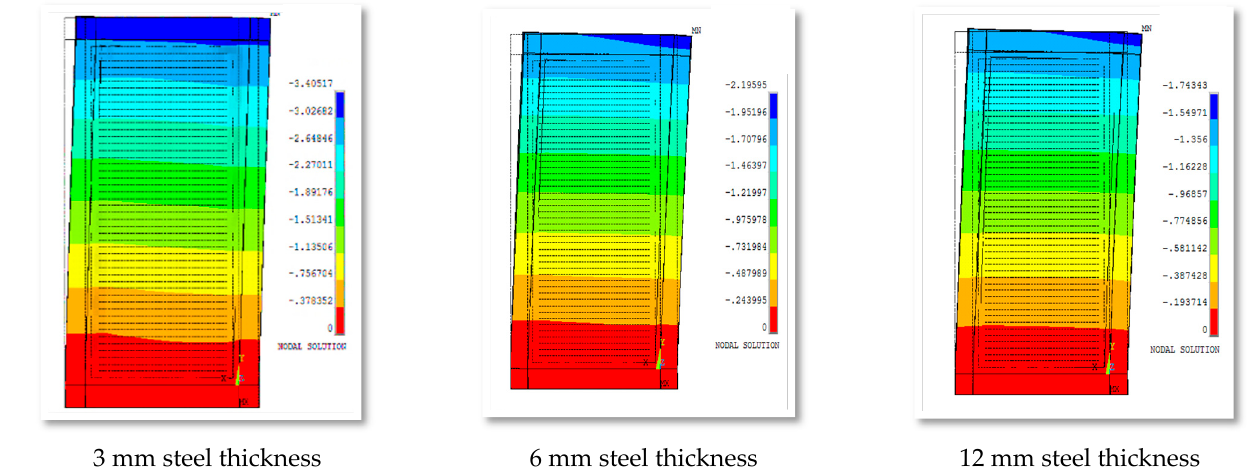
Figure 15. Out-of-plane displacement of group 2 for various steel thicknesses.